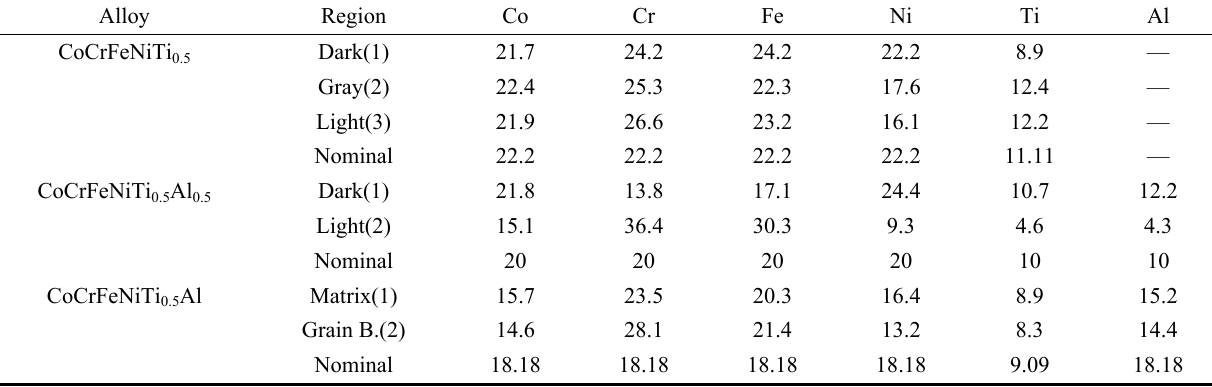
Table 1 Chemical compositions of the as-solidified CoCrFeNiTi 0.5 Al x alloys in atomic percentage (%).